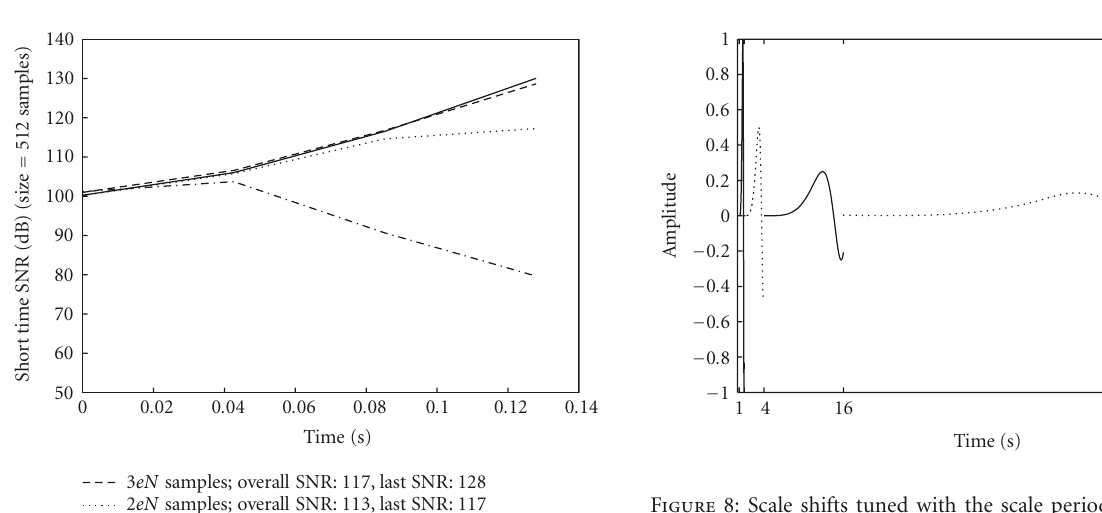
Figure 8: Scale shifts tuned with the scale period of the original signal (the original signal starts at 1 second and ends at 4seconds). One scale-compressed version with the same scale period has been reproduced from 0.25 second to 1second, and two scale-expanded versions with the same scale period are reproduced from 4 seconds to 16 seconds, and from 16seconds to